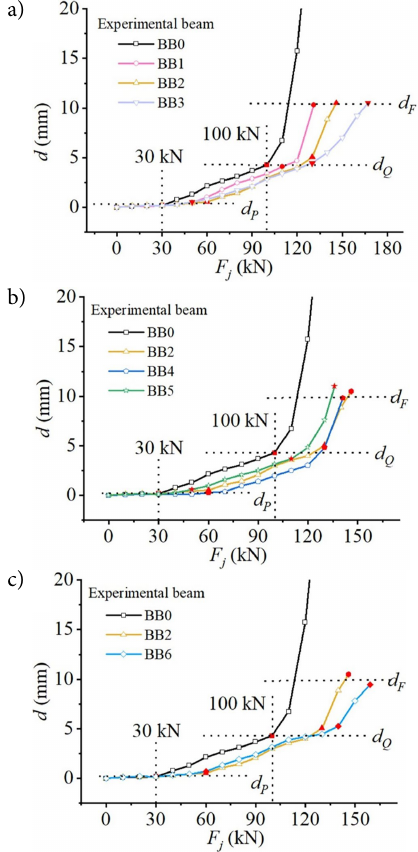
Figure 15. The vertical displacement of different experimental beams: a – The experimental beams with different thicknesses of the FRP grid; b – The experimental beams with different bond lengths of the CRL; c – The experimental beams with different